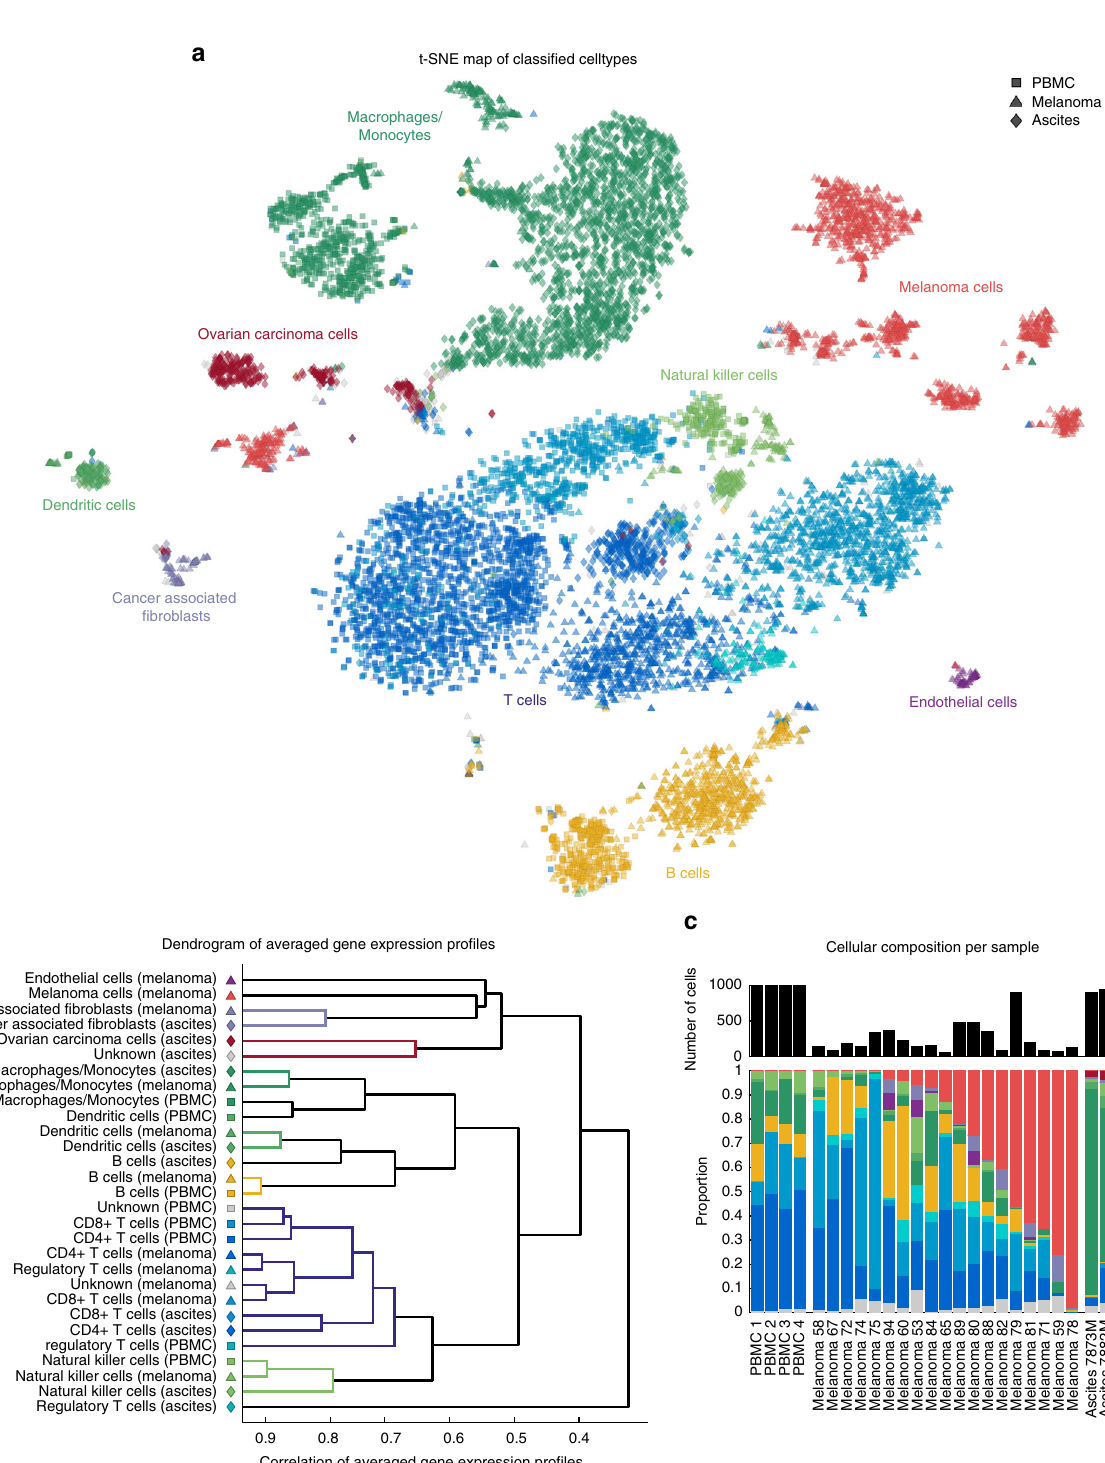
Fig. 1 Comparison of gene expression pro fi les of single cells from different data sources. a Single cells were arranged in two dimensions based on similarity of their gene expression pro fi les by the dimensionality reduction technique t-SNE. The clusters that emerge spontaneously can be associated with cell types (colours) and data source (symbol types: squares for PBMC-data sets, triangles for the melanoma-data sets, and diamonds for ascites data-sets). b Pair-wise correlation of averaged gene expression pro fi les of clusters encoding cell type and origin as identi fi ed in a visualised as dendrogram. c Number of cells and cellular composition per